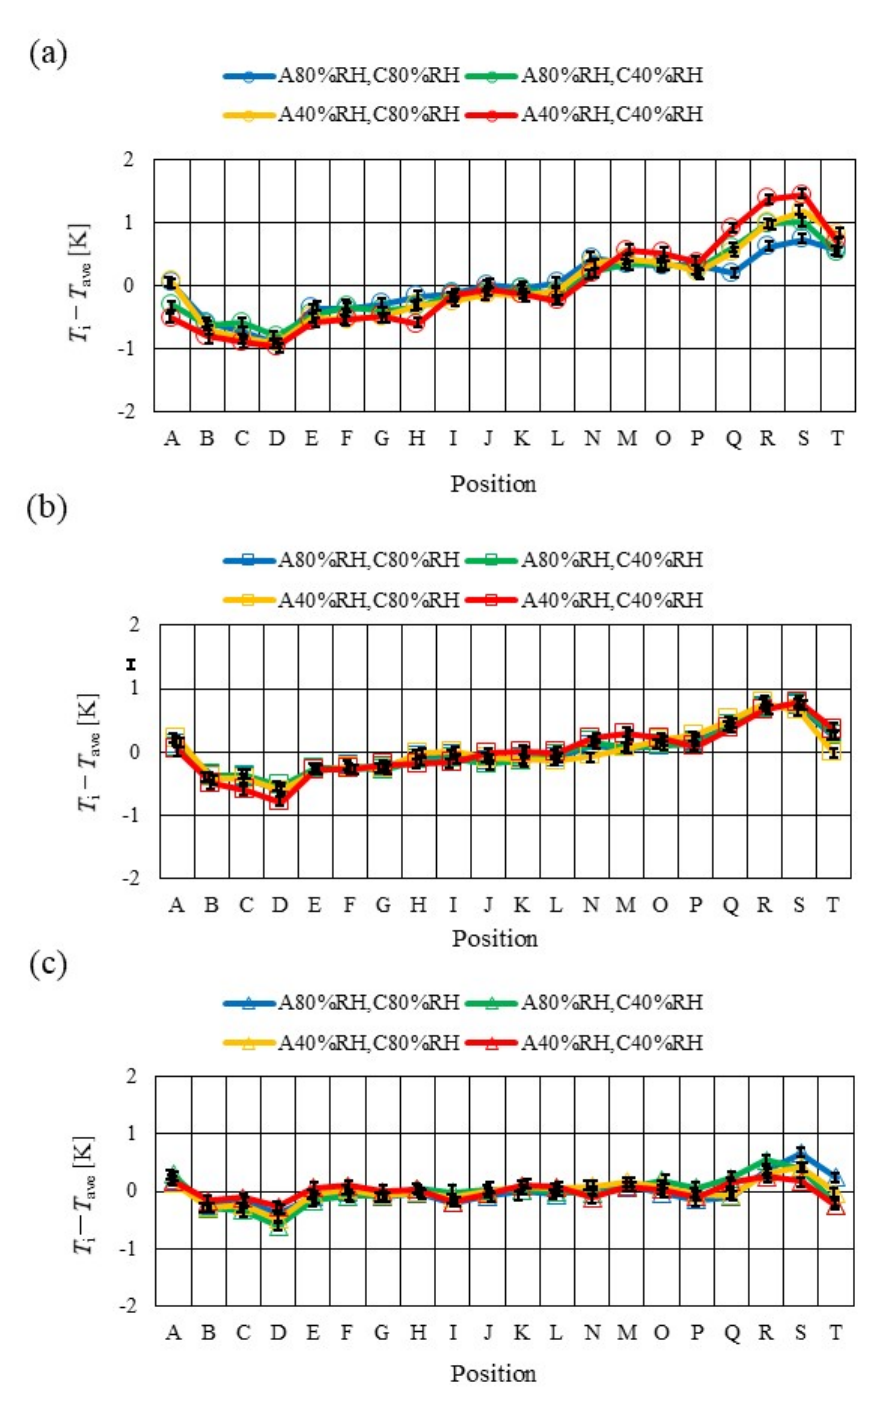
Figure 18. Comparison of in-plane temperature distributions at the cathode side among different RHs in the case of the separator thickness of 1.0 mm: ( a ) T init = 353 K; ( b ) T init = 363 K; ( c ) T init = 373 K.